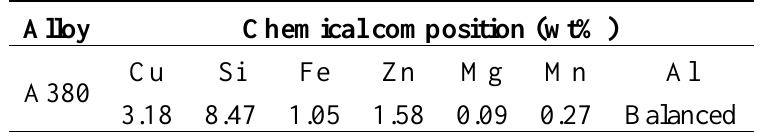
Table1. Mass chemical composition of aluminum alloy ingot.